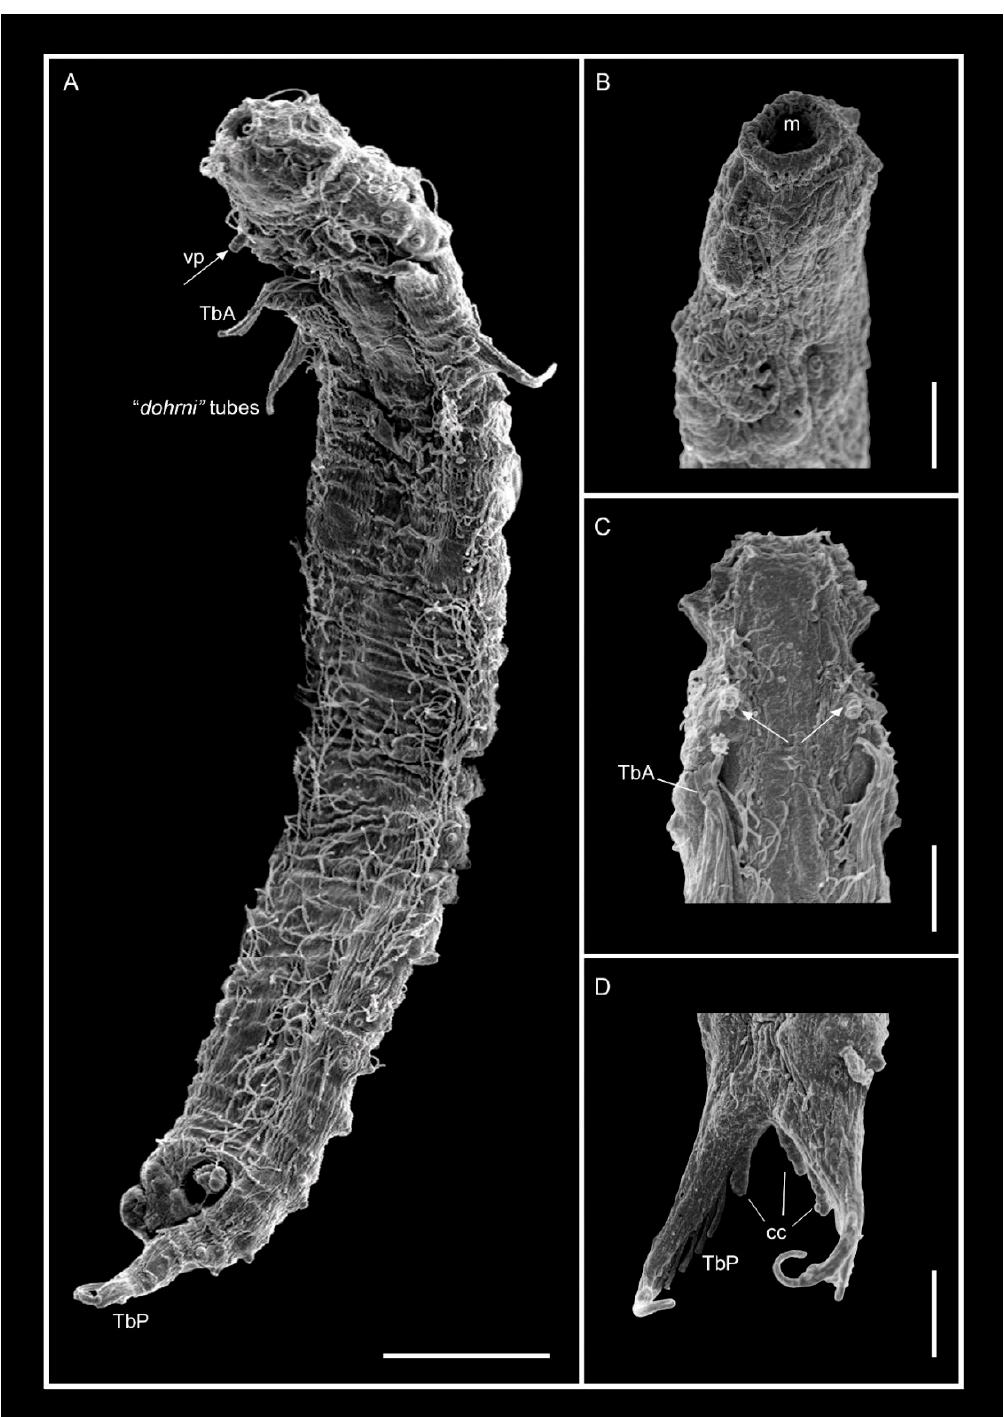
ephemeral male pore (mp). ( D ) Dorsal view of the trunk region showing the frontal organ with a bundle of allosperm inside; the arrowhead indicates the location of the dorsal external pore through which sperm (sp) have been injected. ( E ) Close-up of the spermatozoa bundle inside the frontal organ. Scale bars: A = 100; B , C = 50; D , E = 20 µm.